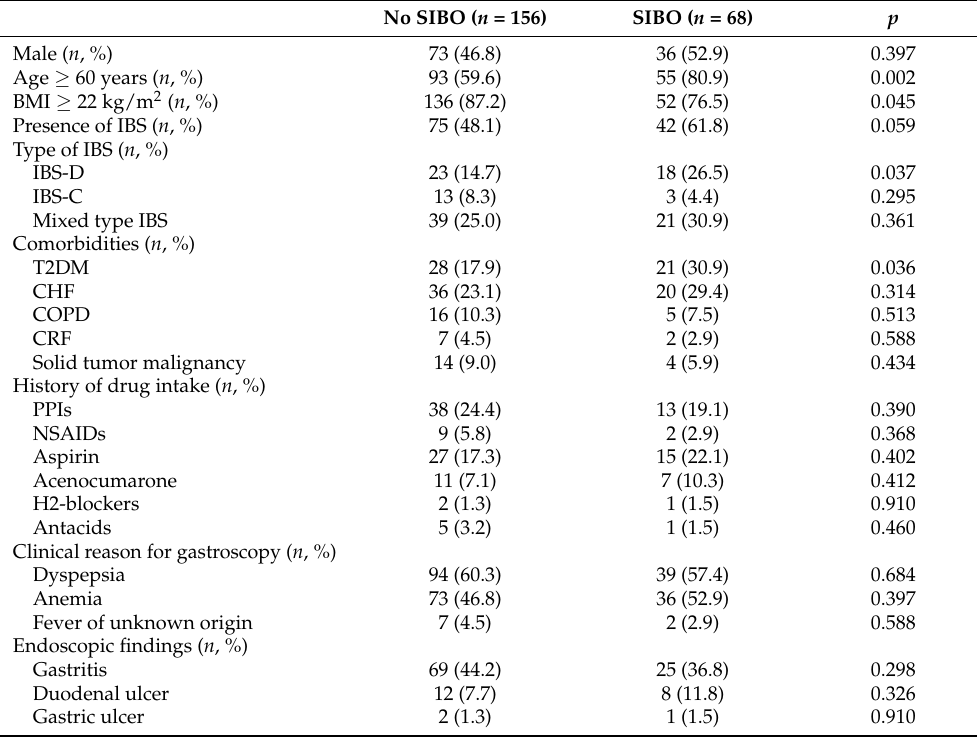
Table 1. Demographic characteristic of enrolled